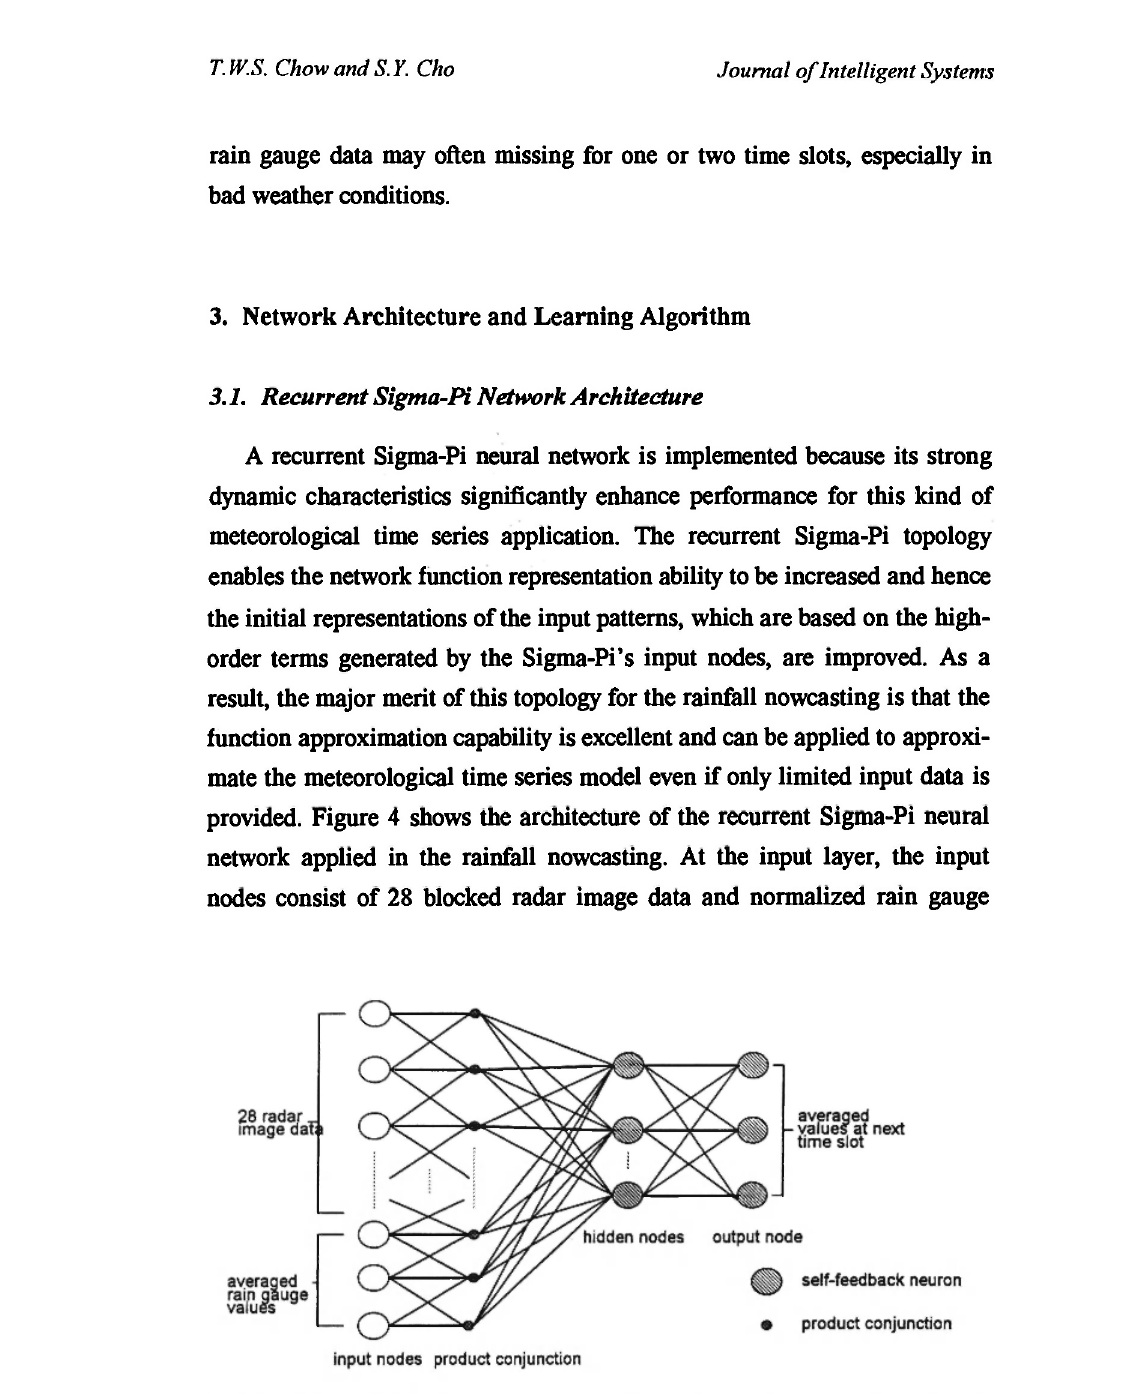
Fig. 4: The architecture of recurrent sigma-pi neural network for rainfall